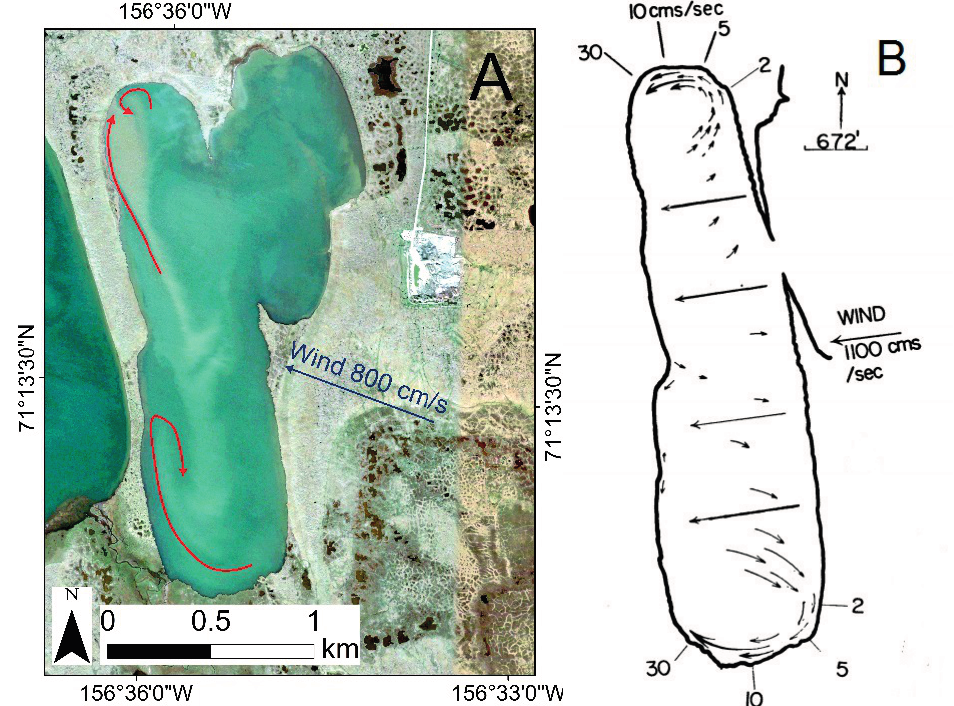
Figure 15. Comparison of gyre patterns observed by WorldView in Loon Lake near Barrow, Alaska on 19 August 2005 ( A ) with flow patterns determined by dye and float experiments by Carson and Hussey [12] ( B ) (Figure B adapted from Carson and Hussey [12] with permission from The Chicago University